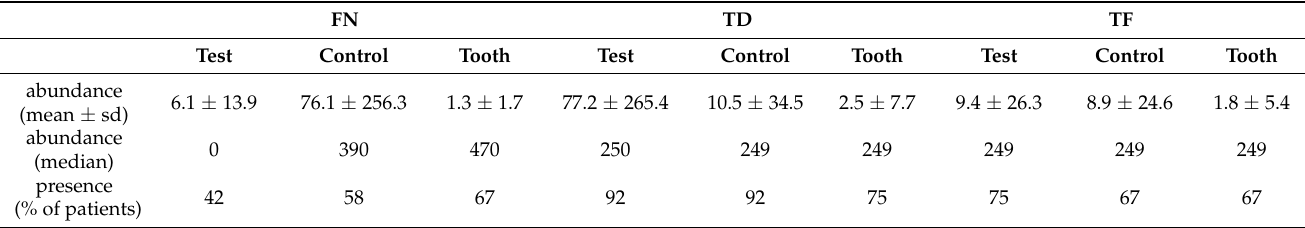
Table 3. Subgingival microbiota from RT-PCR along test, control implants, and adjacent teeth. FN TD